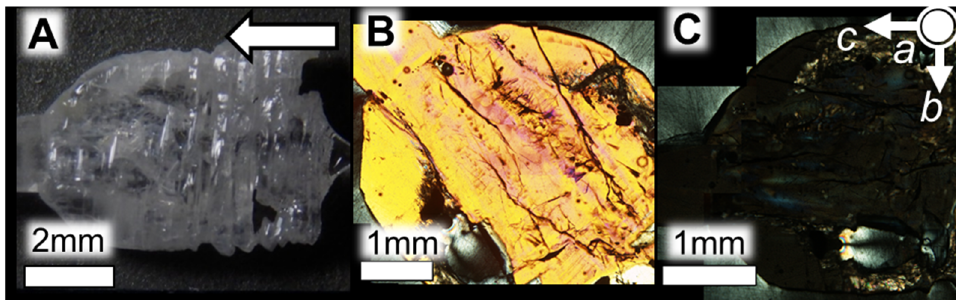
Figure 2. SBO crystal fibers grown without the application of voltage: ( A ) external form of SBO crystals; ( B ) SBO crystals observed by polarized optical microscopy; ( C ) the test piece of ( B ) rotated by 45°. A white arrow corresponds to the pulling-down direction. Symbols in ( C ) correspond to the crystallographic orientation of seed crystals.